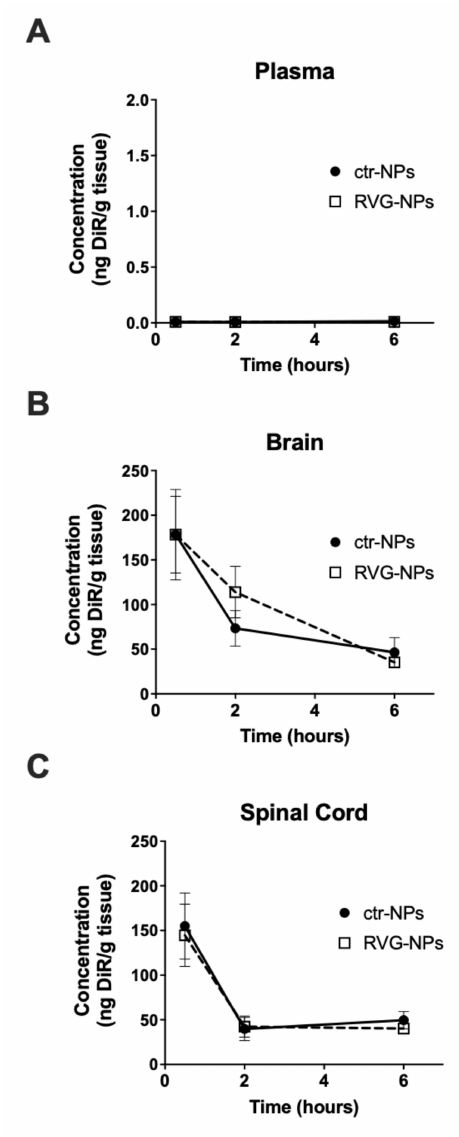
Figure2. Time-dependentconcentrationprofilesof1,1 (cid:48) -Dioctadecyl-3,3,3 (cid:48) ,3 (cid:48) -Tetramethylindotricarbocyanine Iodide (DiR)-loaded poly(lactic- co -glycolic acid) (PLGA) nanoaprticles following intranasal administration. Concentration of DiR in ( A ) blood plasma, ( B ) whole brain, and ( C ) whole spinal cord after intranasal administration. Graphs show the mean ± SEM ( n =